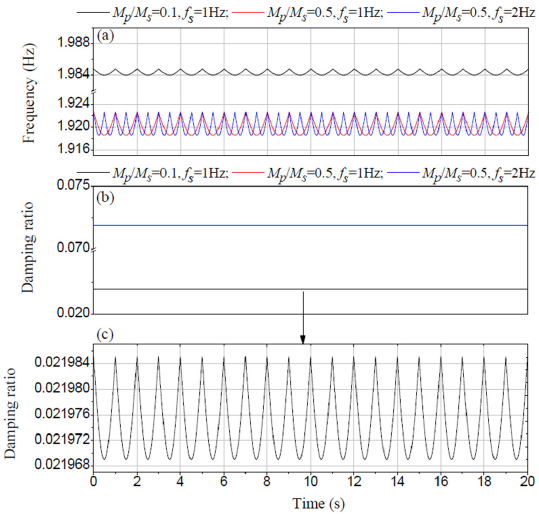
Figure 4. Effect of step frequency and crowd size on dynamic properties: ( a ) the larger mass ratio M p / M s results the lower natural frequencies of structure, which is altered following the step rate; ( b ) the larger mass M p / M s results the larger damping of structure; ( c ) damping of occupied structure is altered following the step rate 1 Hz under the mass ratio M p / M s =